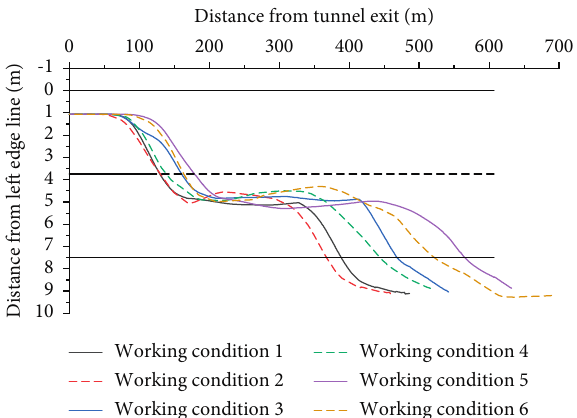
Figure 6: Vehicle trajectories under different working conditions of the third service